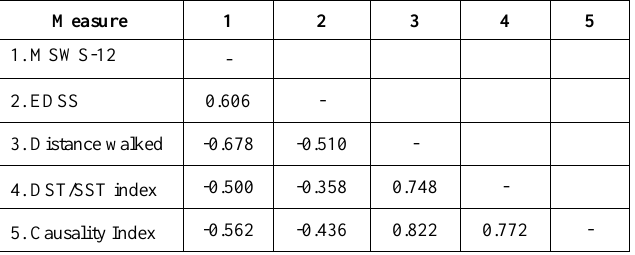
Figure 3. Distribution of (a) Causality Index, (b) Distance walked, (c) MSWS-12 scores, and (d) DST/SST index in three groups: healthy controls, mild and moderate MS subjects. The causality index distinguishes the three groups most clearly. limited variability in MSWS-12 scores, impeding correlations between the MSWS-12 and other measures. Table 1. Bivariate correlations among MSWS-12 scores, EDSS scores, distance walked, other quantitative measures drawn from inertial sensor data (causality index and DST/SST